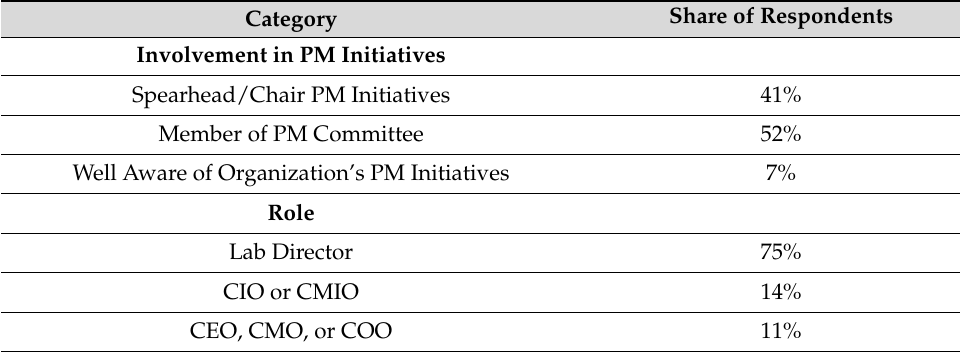
Table 2. Survey respondent